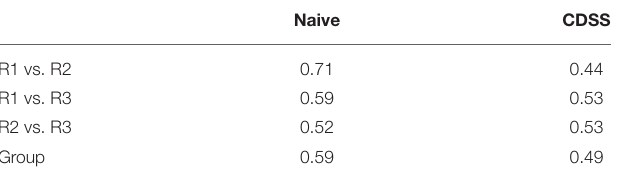
TABLE 2 | Inter-rater reliability for known seizure events.